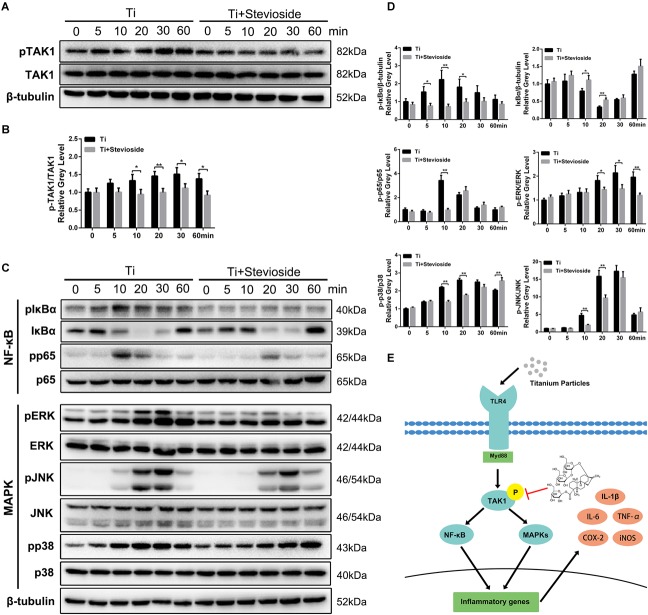
(A,C) BMMs were pretreated with or without 200 μM stevioside for 4 h and then treated with 0.1 mg⋅mL-1 Ti particles for the indicated periods. Cell lysates were analyzed using western blotting. (B) The gray level of phosphorylated TAK1 was normalized relative to TAK1. (D) The gray levels of phosphorylated p65, ERK, JNK, and p38 were quantified and normalized relative to total p65, ERK, JNK, and p38. The gray levels of phosphorylated IκBα and IκBα were normalized to β-tubulin. (E) Schematic representation of the experiments presented in this figure. Data are presented as mean ± SD. ∗P < 0.05, ∗∗P < 0.01, compared with Ti particles alone.